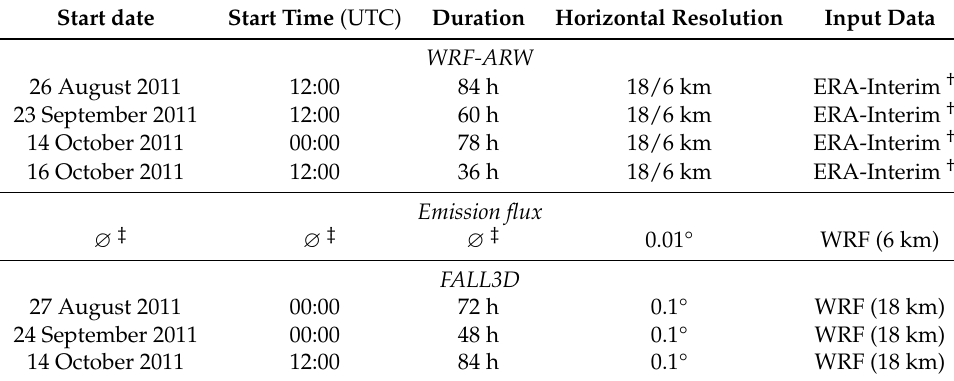
Figure 7. Initial fields of upper soil moisture using two WRF-ARW configurations. ( a ) Rapid Update Cycle (RUC) land-surface model initialised directly from ERA-Interim re-analysis data; and ( b ) RUC land-surface model considering a 30-days period for soil spin-up. In both cases, results correspond to the inner WRF domain with horizontal resolution of 8 km. Table 1. Configuration of numerical